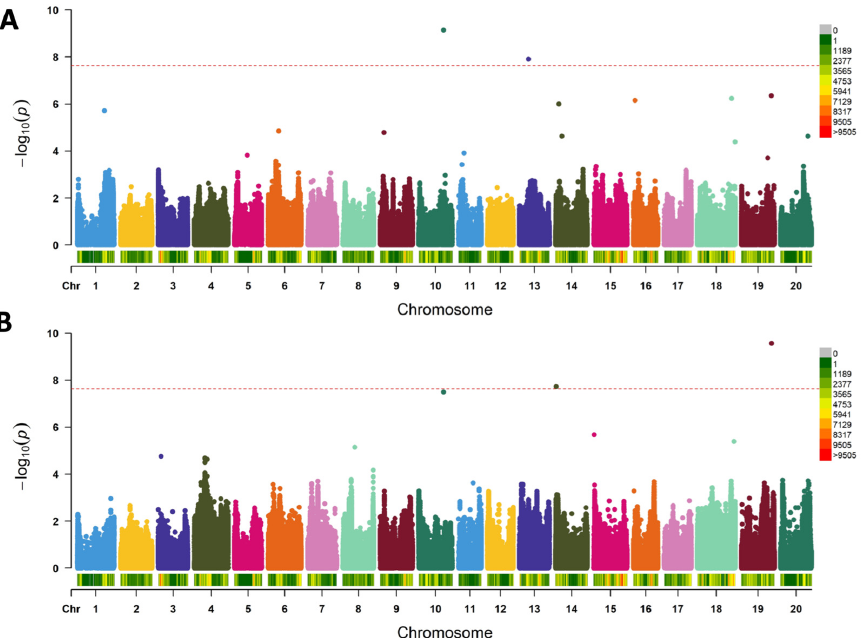
Figure 3. Manhattan plots showing significantly associated SNPs detected in genome-wide associ- ation results for percentage nitrogen derived from the atmosphere (%Ndfa) under ( A ) %Ndfa—30% field capacity (FC); ( B ) %Ndfa—relative performance. Relative performance was calculated as the ratio of %Ndfa under 30% FC vs. 80% FC. Negative log 10 ( p -values, y -axis) describing the strength of the association between each marker and trait are plotted against the physical position of each marker ( x -axis). The pink dashed line indicates the significance threshold (FDR = 5%) and beyond that are considered as significant associations. Each colored dot represents a SNP.